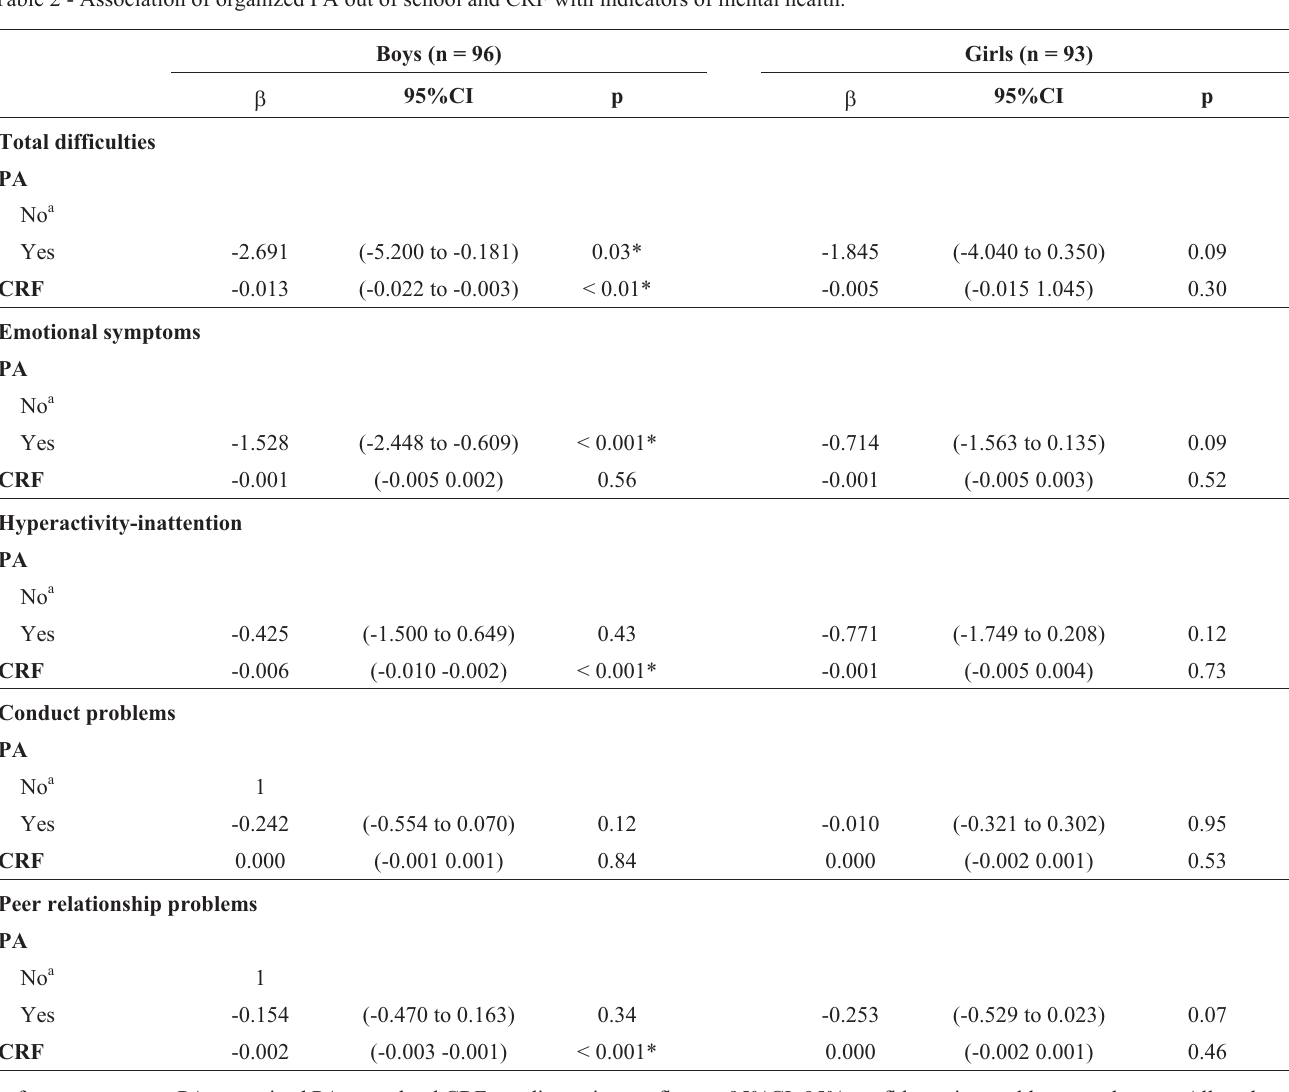
Table 2 - Association of organized PA out of school and CRF with indicators of mental